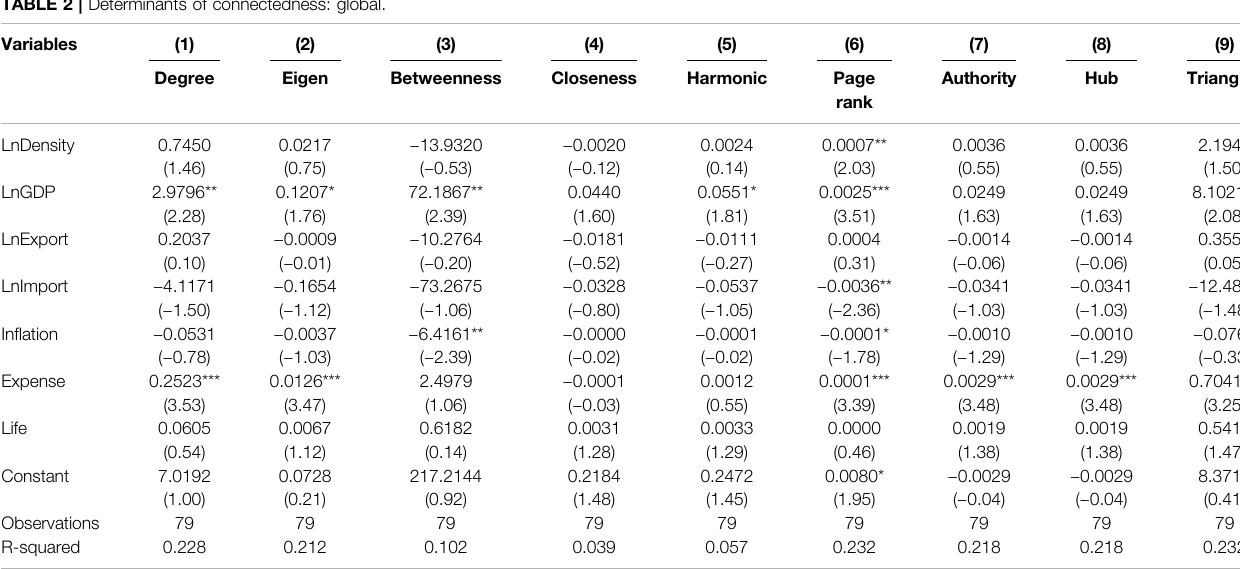
TABLE 2 | Determinants of connectedness: global. Variables